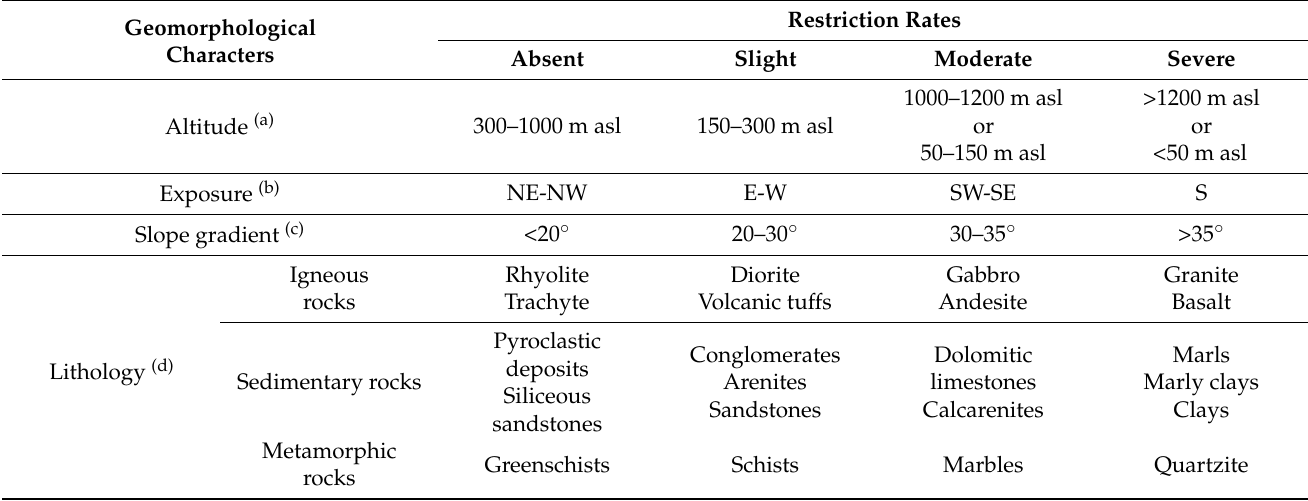
Table 2. Restriction rates for Castanea sativa Mill. cultivation for fruit production related to altitude, exposure, slope gradient, and